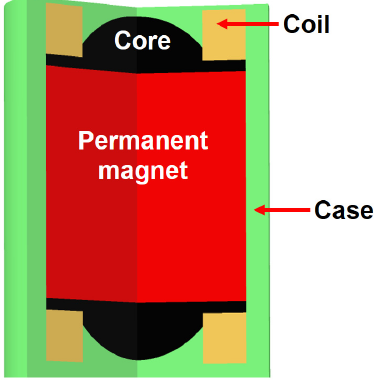
Figure 14. Numerical model of the ferrous particle sensor.